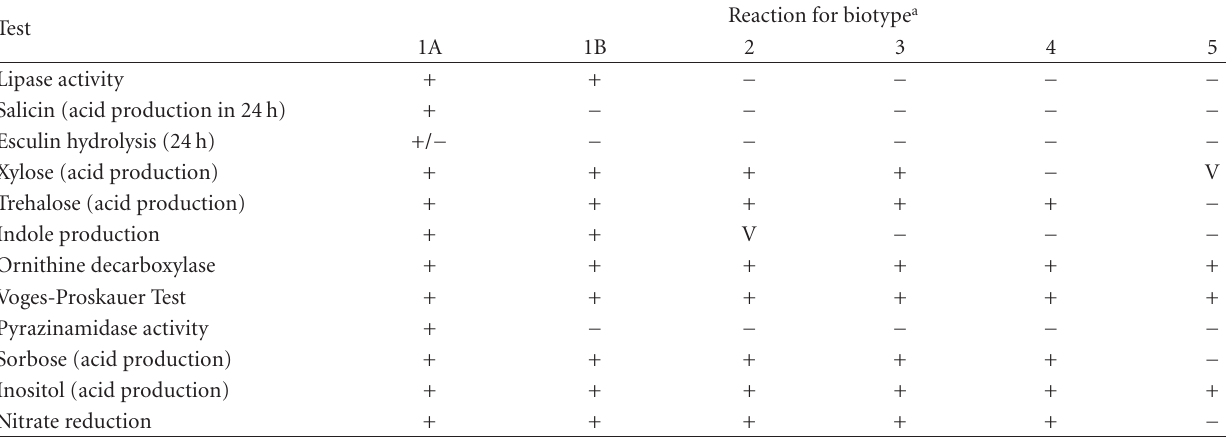
Table 1: Biochemical tests used to biogroup Y. enterocolitica strains.